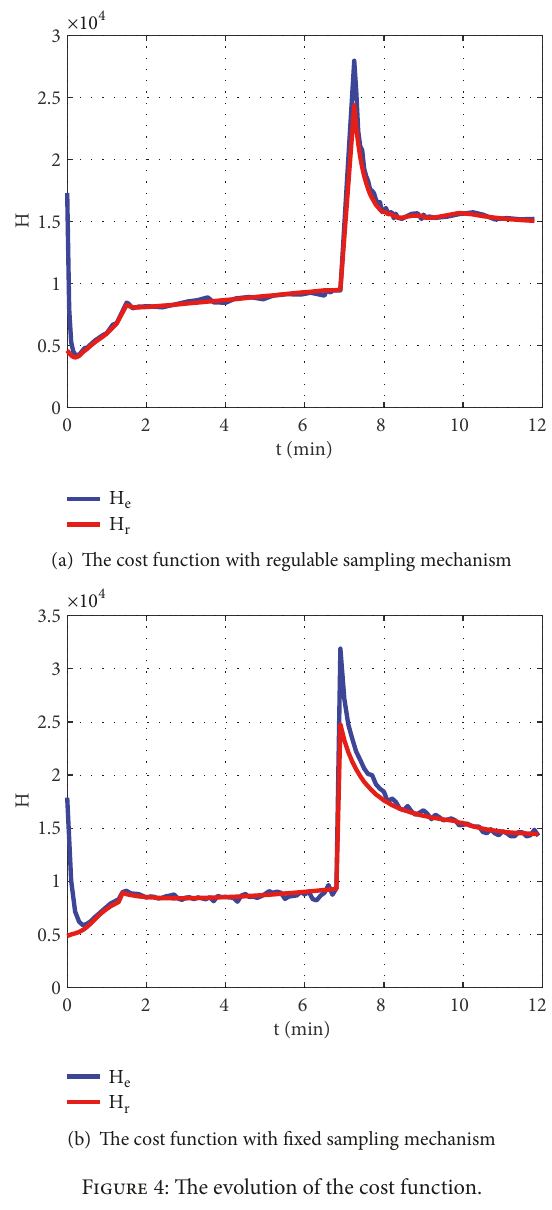
Figure 3: The distances from the agents to their centroids.